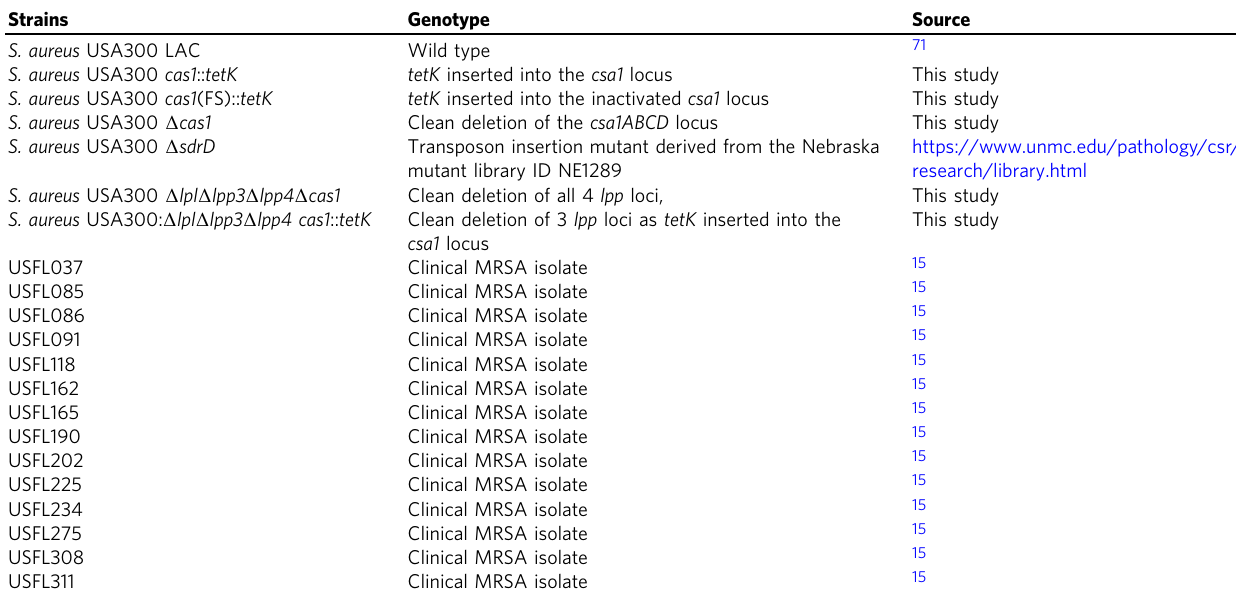
Table 1 Bacterial strains used in this